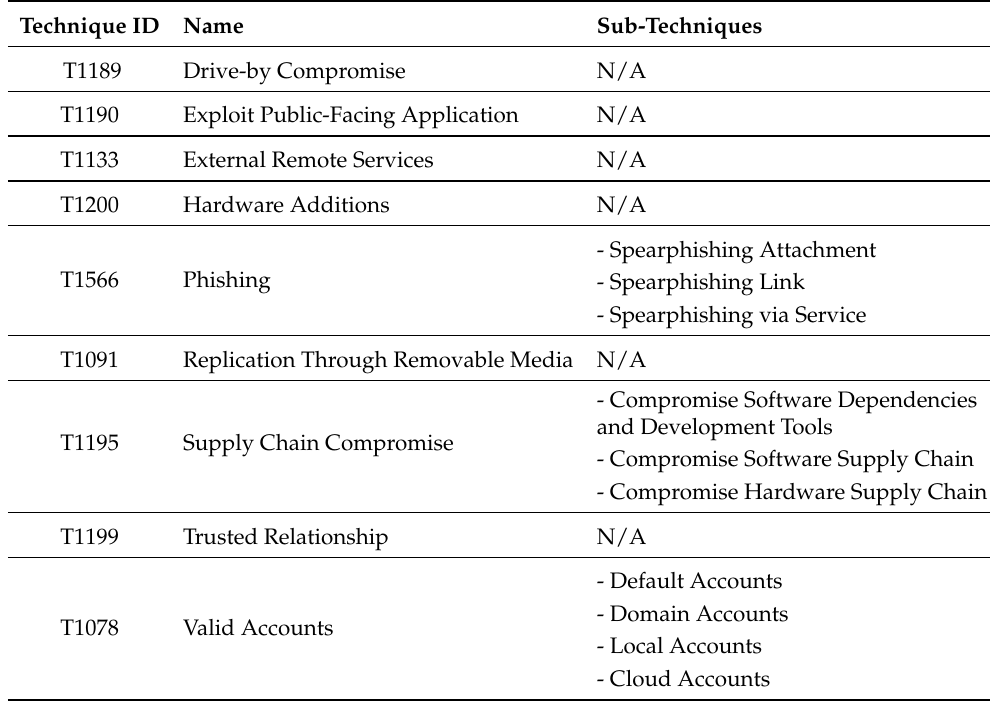
Table 3. MITRE ATT&CK Initial Access